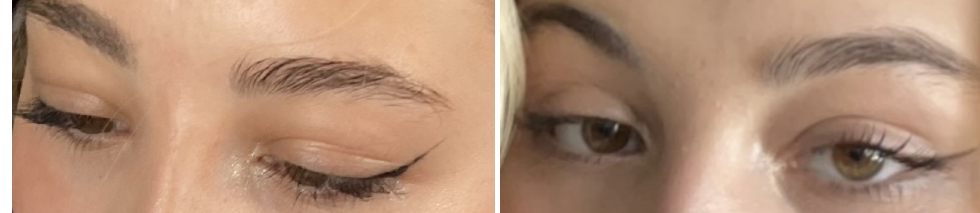
Figure 4. Improvement of oedema began during the sixth week ( left ) and complete resolution occurred in the eighth week ( right